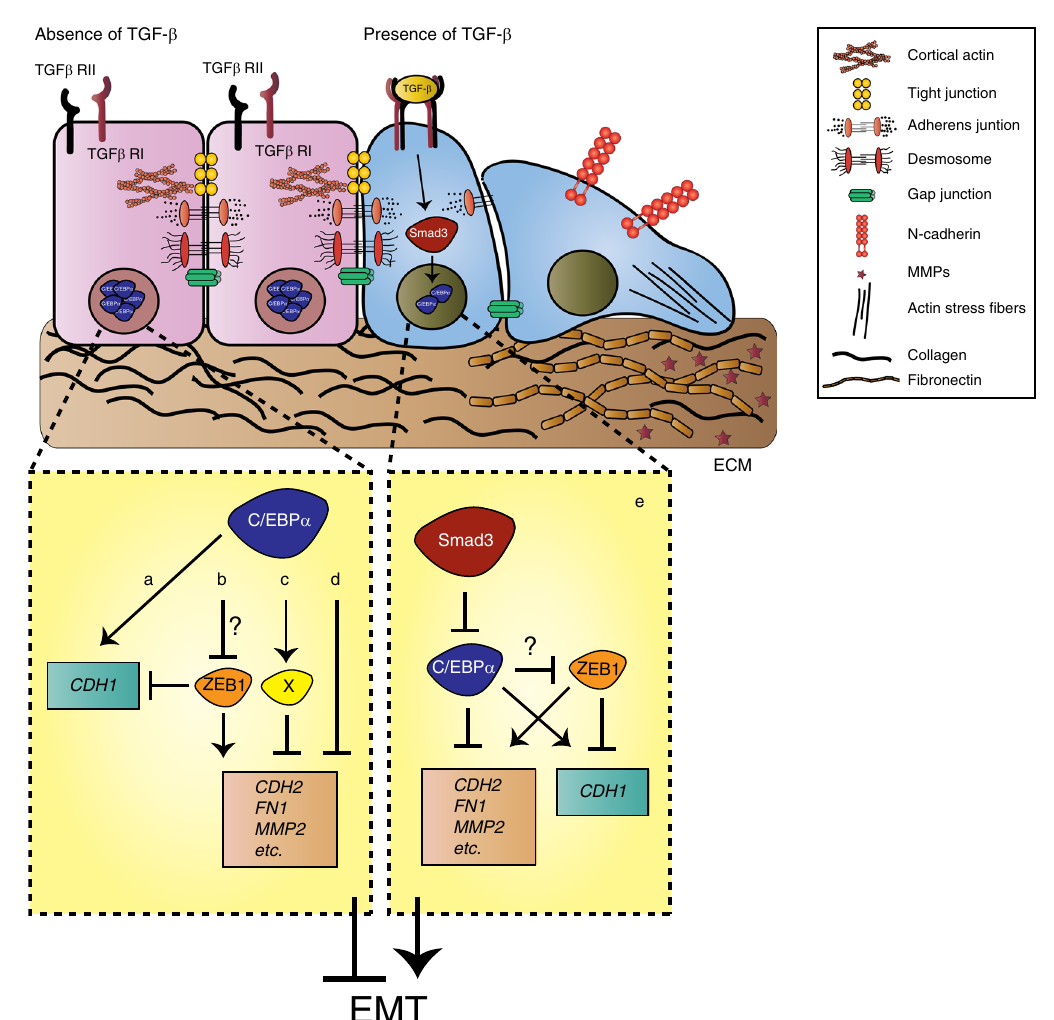
Fig. 8 Schematic model for C/EBP α function during epithelial homeostasis and TGF- β -mediated EMT. In non-transformed mammary epithelial cells, epithelial homeostasis is ensured by high levels of C/EBP α , which negatively regulates the expression of pro-mesenchymal proteins. C/EBP α -mediated repression of unwarranted EMT might be due to ( a ) direct transcription of epithelial proteins such as E-cadherin and ( b ) suppression of the EMT-inducer ZEB1. ZEB1 itself is able to directly repress CDH1 (E-cadherin) expression and induce the transcription of several mesenchymal genes, including CDH2 (N-cadherin) and MMP2 . c Also, C/EBP α -mediated activation of an intermediate transcriptional repressor may be responsible for impairing EMT and/or ( d ) direct transcriptional repression by C/EBP α . Upon deregulation of TGF- β signaling, induction of EMT is induced by SMAD3-mediated inhibition of C/ EBP α and ( e ) repression of EMT is